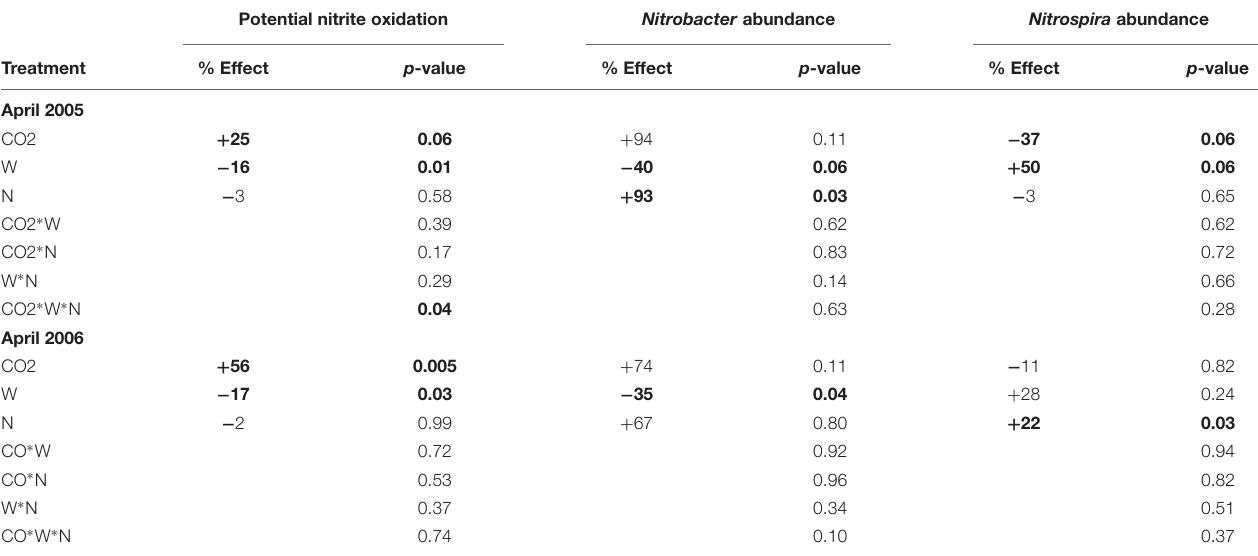
TABLE 1 | p -values from three-way split-plot analysis of variance testing for the effects of global change scenarios on potential nitrite oxidation and abundance of Nitrobacter -like NOB and Nitrospira at the end of the 7th and 8th plant growing seasons under treatments (April 2005 and April 2006,